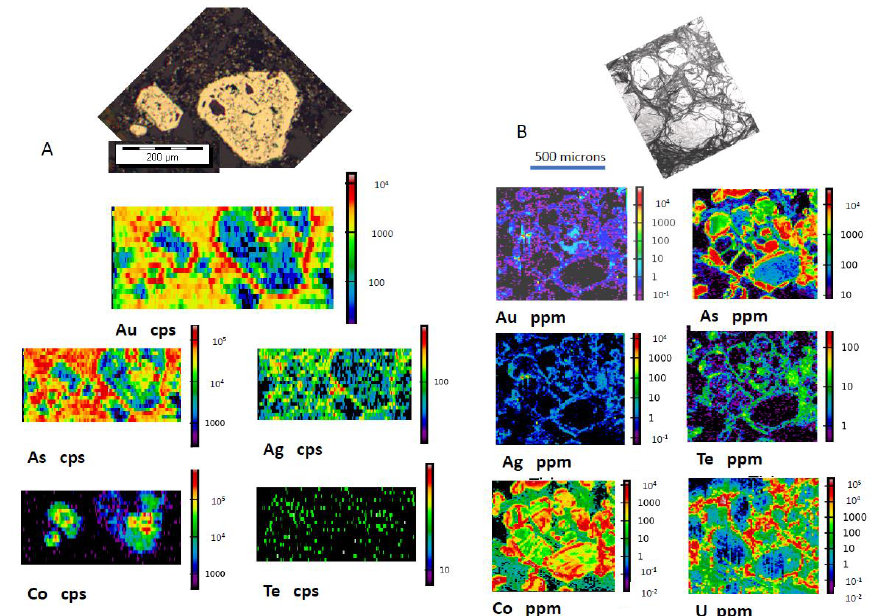
Figure 5. ( A ) LA-ICPMS map of pyrite in cps from Carlin deposit Gold Quarry showing the characteristic Au-As rim on pyrite and Co-rich core to the pyrite. ( B ) LA-ICPMS map in ppm of a cluster of detrital pyrites from the Witwatersrand Carbon Leader Reef. The hydrothermal rims on detrital pyrites are enriched in As, Ag, Co, Te, Au and U. Free gold grains are present in some CLR pyrite rims, as shown by the laser mapping, as bright red and yellow spots in Figures 5B and 6. The mean invisible gold content of the rims mapped in